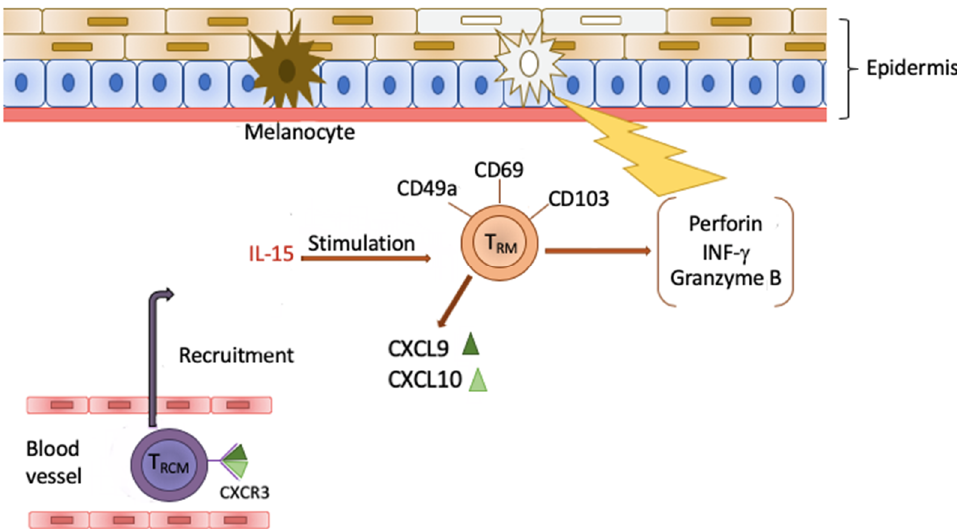
Figure 1. T RM cells demonstrate expression of CD49a, CD69 and CD103 particles. Due to the stimulation of IL-15, they secreting perforin, granzyme B and IFN- γ , indicating in this way a cytotoxic e ff ect on melanocytes. Additionally, T RM produce chemokines CXCL9 and CXCL10, which, after binding with receptor CXCR3 on the surface of T RCM cells, influence their recruitment from the blood vessels to the skin. Next, through the synergistic e ff ect, they cause the depigmentation of the skin in the course of disease.